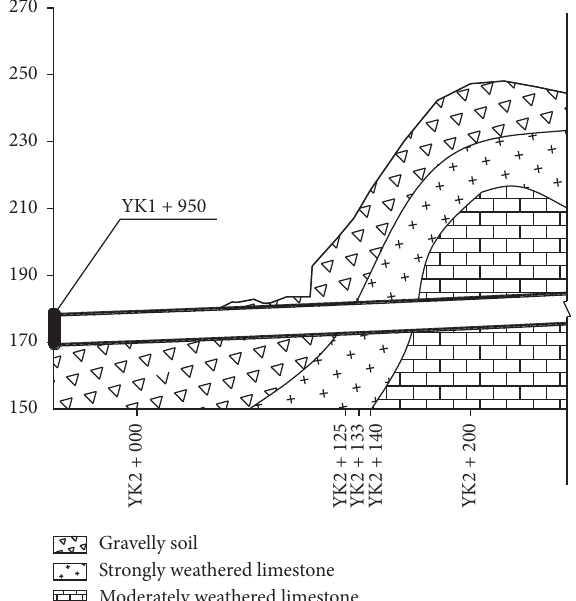
Figure 7: Monitoring sections in tunnel portal.